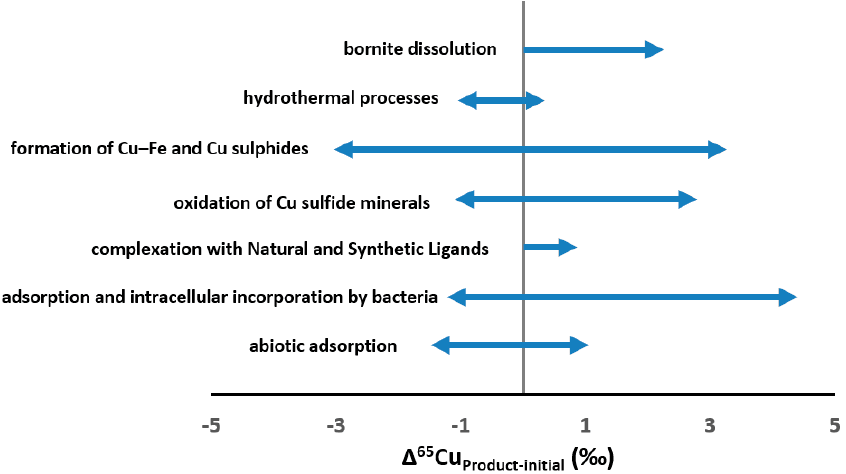
Figure 1. Fractionation( Δ 65 Cu) of Cu isotopesin low temperature processes [37–40,42–45,47,48,50,52–54,56,57].